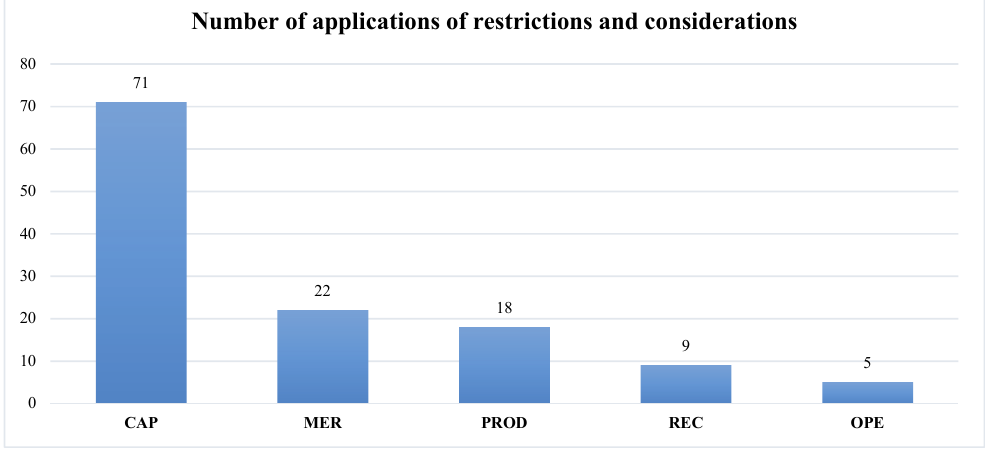
Fig. 15. Distribution of restrictions and